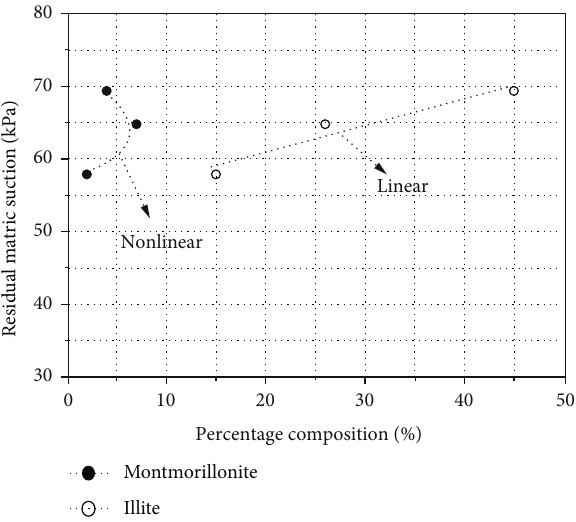
Figure 10: Relationship between metric suction content and content of clay